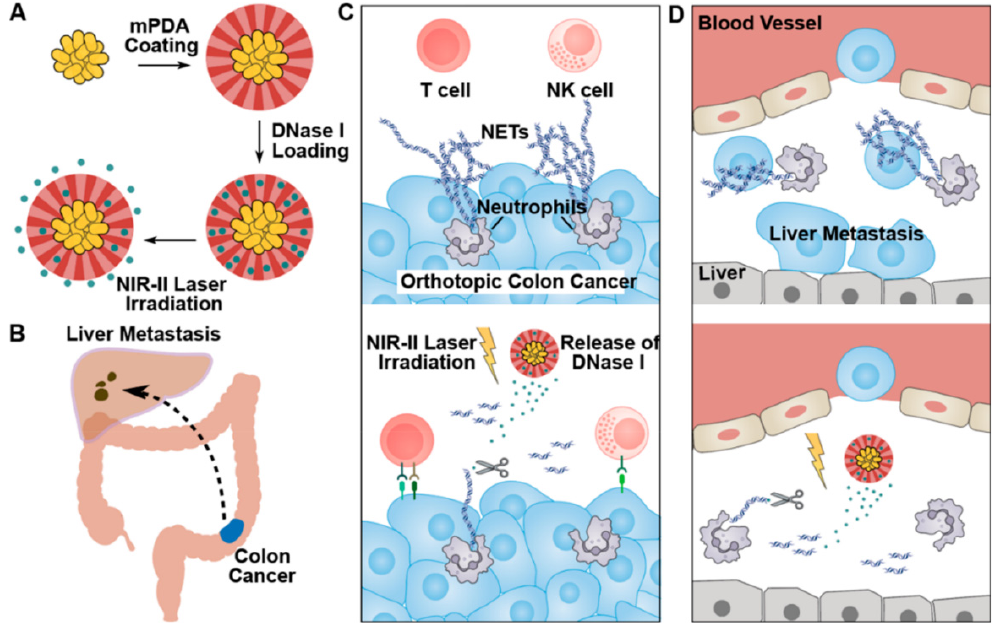
Figure 4. Synthesis and schematic diagram of dopaminergic and gold nanoparticles loaded with DNase for cancer therapy. ( A , B ) The process of DNase I delivery and liver matastasis of colon cancer. ( C , D ) Biodegradation and anticancer effect of synthesized system. The strategy reveals the movement process and delivery mode of nanoparticles and illustrates the activation of immune cells. Reprinted with permission from Ref. [63]. Copyright 2022 ACS